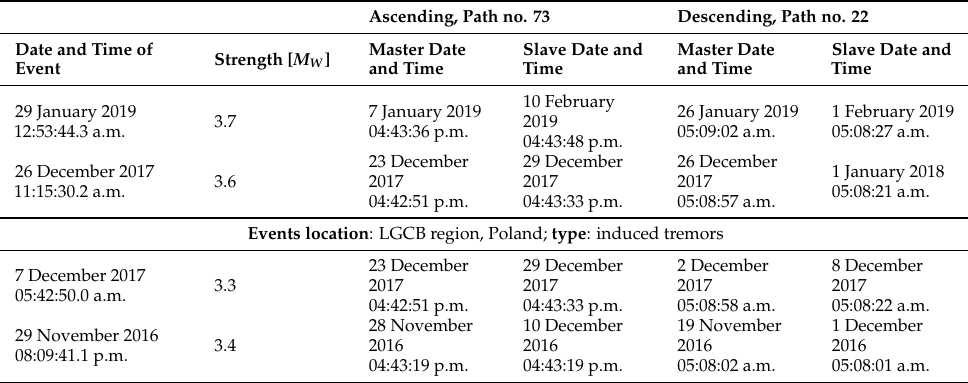
Table 3. Scene-acquisition data: basic information.